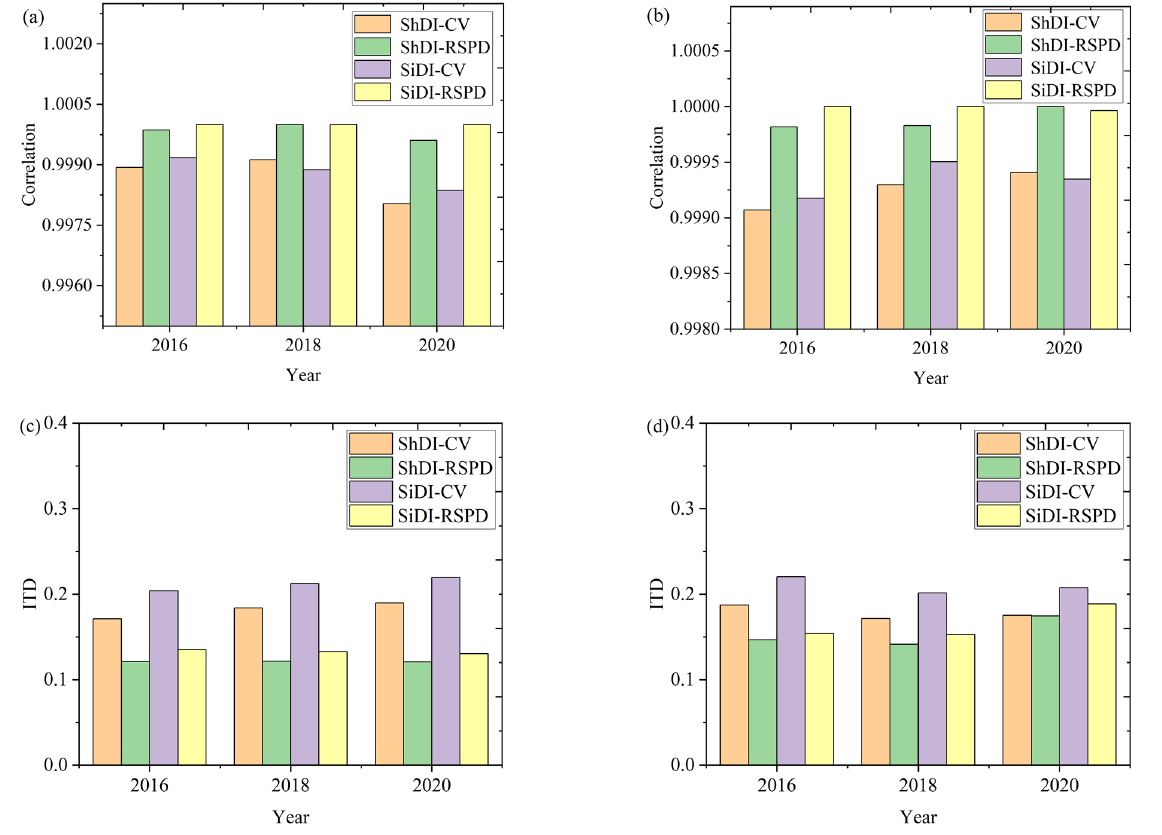
Figure 6. The correlation and image texture difference (ITD) between different methods and ShDI/SiDI (( a ) is the correlation result of Case I; ( b ) is the correlation result of Case II; ( c ) is the ITD result of Case I; ( d ) is the ITD result of Case II).